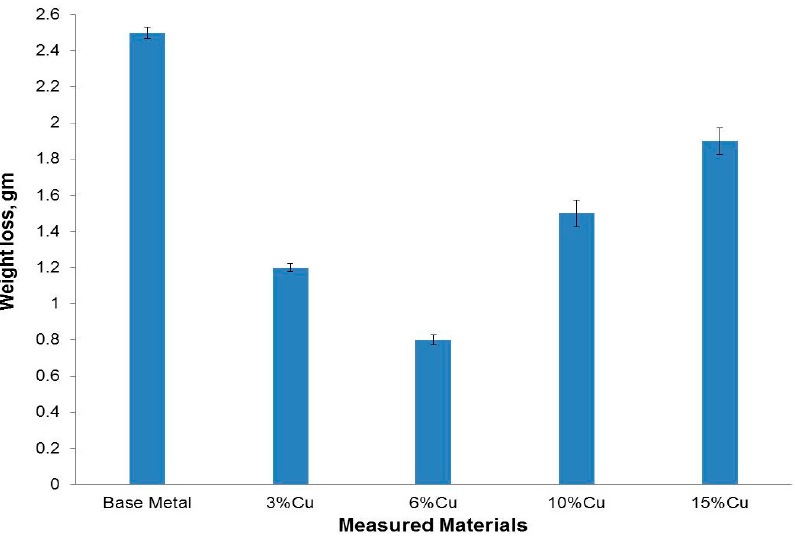
Figure 13. Wear loss values of the Al-12% Si base metal and the formed composites after the addition of copper powder with different weight percentages.